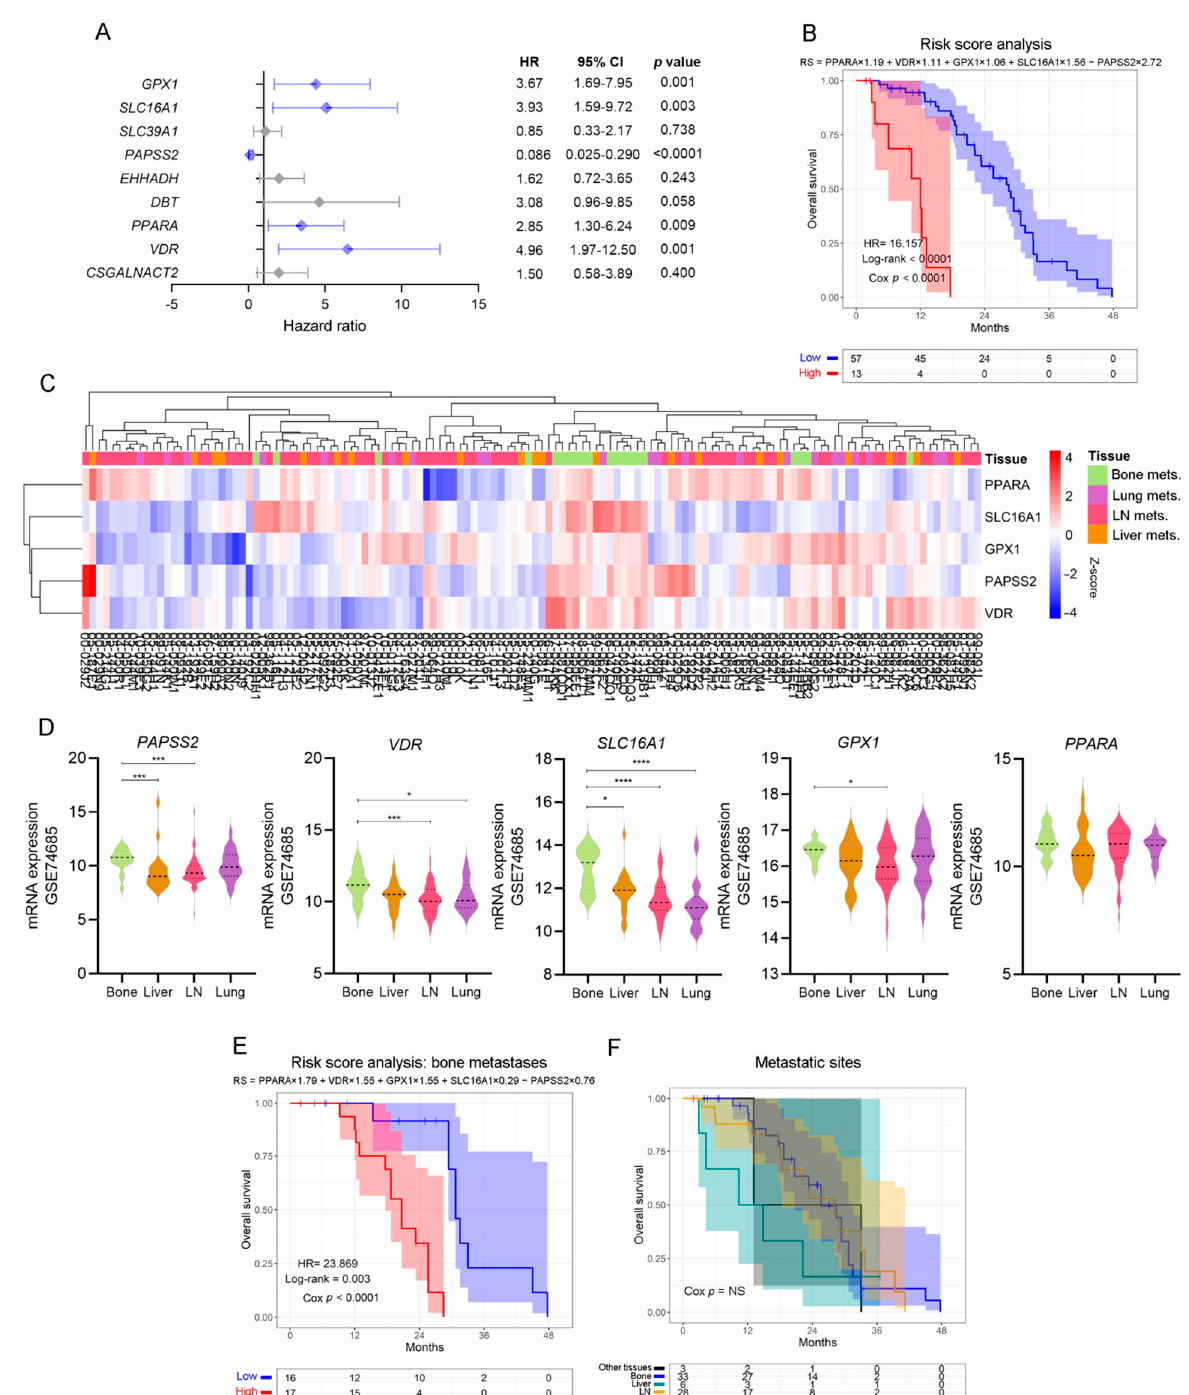
Figure 4. Patient stratification by independent, lipid metabolic-associated death risk predictors. ( A ) Multivariable analyses presented by a forest plot between statistically significant genes in the univariable analyses, using metastatic PCa patients’ data from the SU2C-PCF dataset. All comparisons consider low expression patients as the reference group. Light blue lines correspond to statistically significant independent genes ( p < 0.05). ( B ) KM curve for OS in high-risk (red) and low-risk (blue) groups, according to a risk score model based on the expression of PPARA , VDR, SLC16A1, GPX1 and PAPSS2 , in PCa metastatic patients from the SU2C-PCF dataset. ( C ) Heatmap depicting an unsupervised clustering analysis showcasing the expression of metastatic samples from the